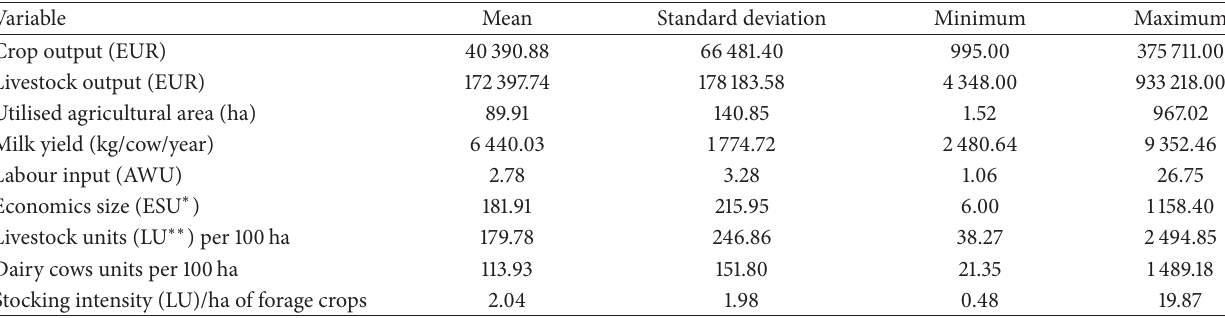
Table 2: Basic descriptive statistics of farms in 2011 ( 𝑁 = 108